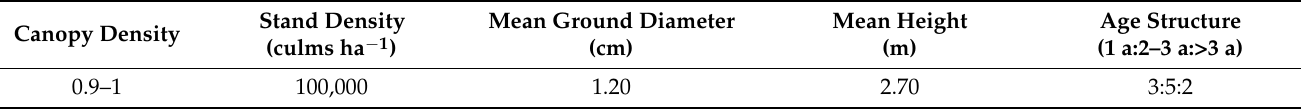
Table 1. The characteristics of the bamboo-forest stands before the experiment. Stand Density Mean Ground Diameter Canopy Density